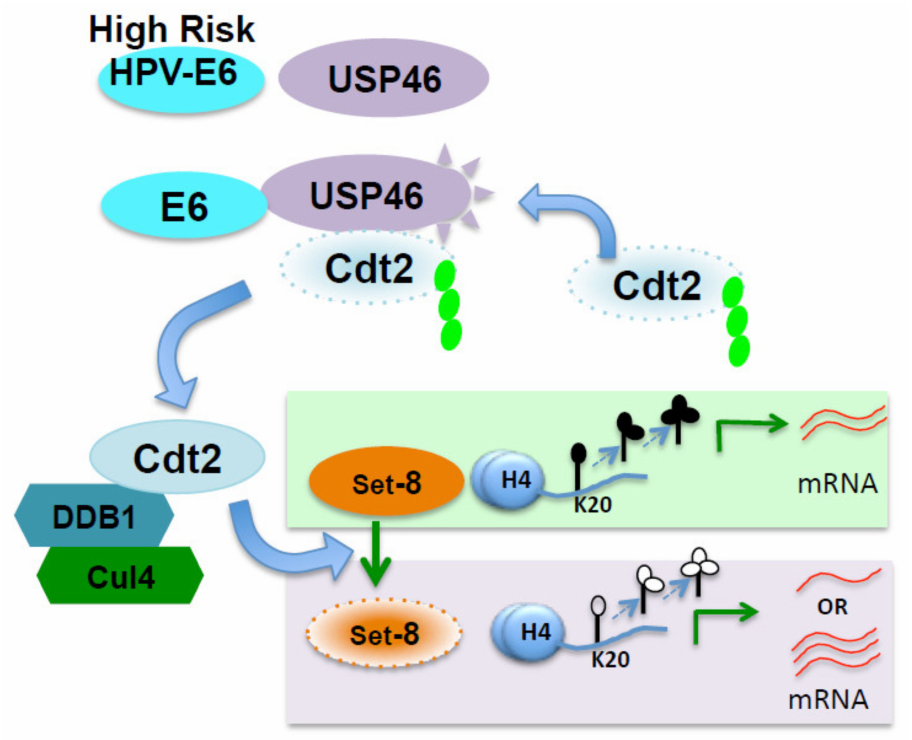
Figure 6. Model summarizing the role of the E6-USP46 complex in HPV induced cancers: E6 from high-risk HPVs engage with and activate the deubiquitinase activity of USP46. The complex then interacts with and stabilizes Cdt2, which in turn degrades the H4K20 mono-methyl-transferase Set8 resulting in decreased levels of H4K20 mono, di and tri methylations at H4K20. Depending on the gene this results in up or down regulation of several genes (like